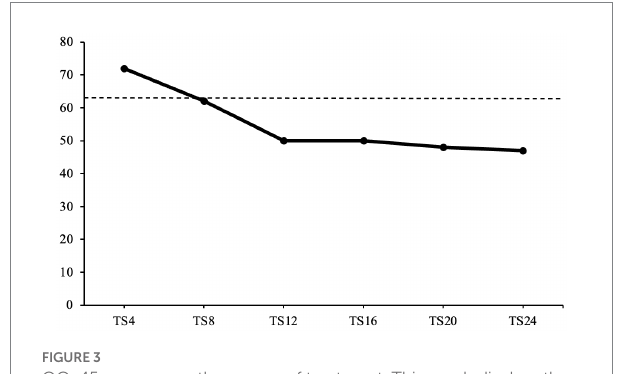
FIGURE 3 OQ-45 scores over the course of treatment. This graph displays the patient’s OQ-45 scores over the course of treatment. TS, therapy session. Dashed line represents the cut-off threshold at score